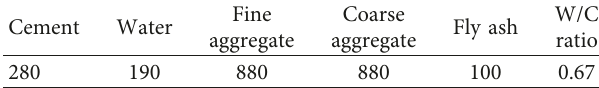
Table 1: Concrete mixture proportions (kg/m 3 ).